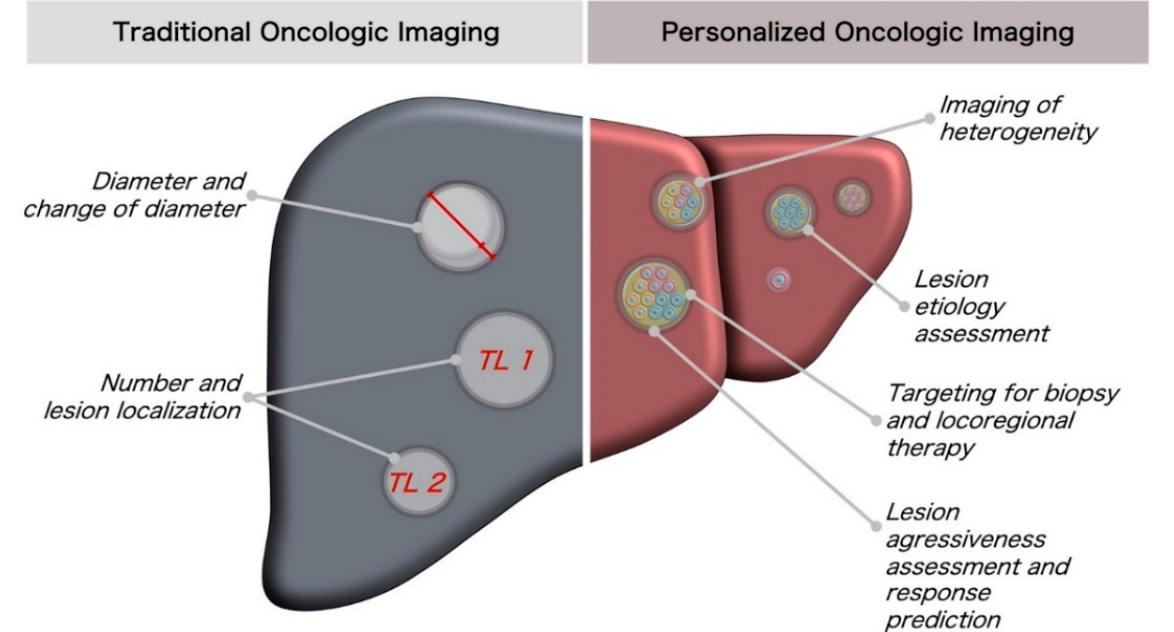
Figure 1. Comparison of traditional oncologic imaging approaches and quantitative imaging biomarkers for better lesion characterization toward personalized oncologic imaging .